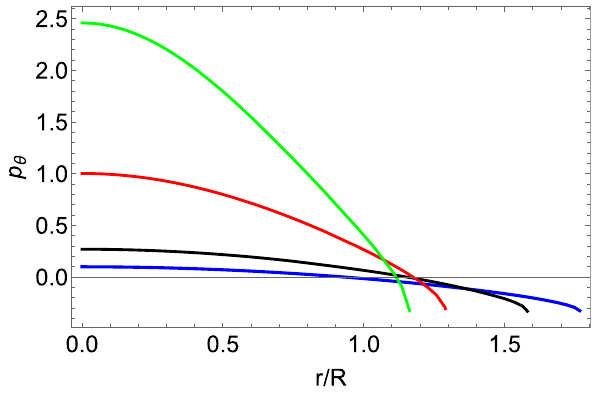
Fig. 12 p θ for u = 0 . 16 (blue line), u = 0 . 2 (black line), u = 0 . 3 (red line), u = 0 . 37 (green line) and (cid:13) = 1 with a more extended radial